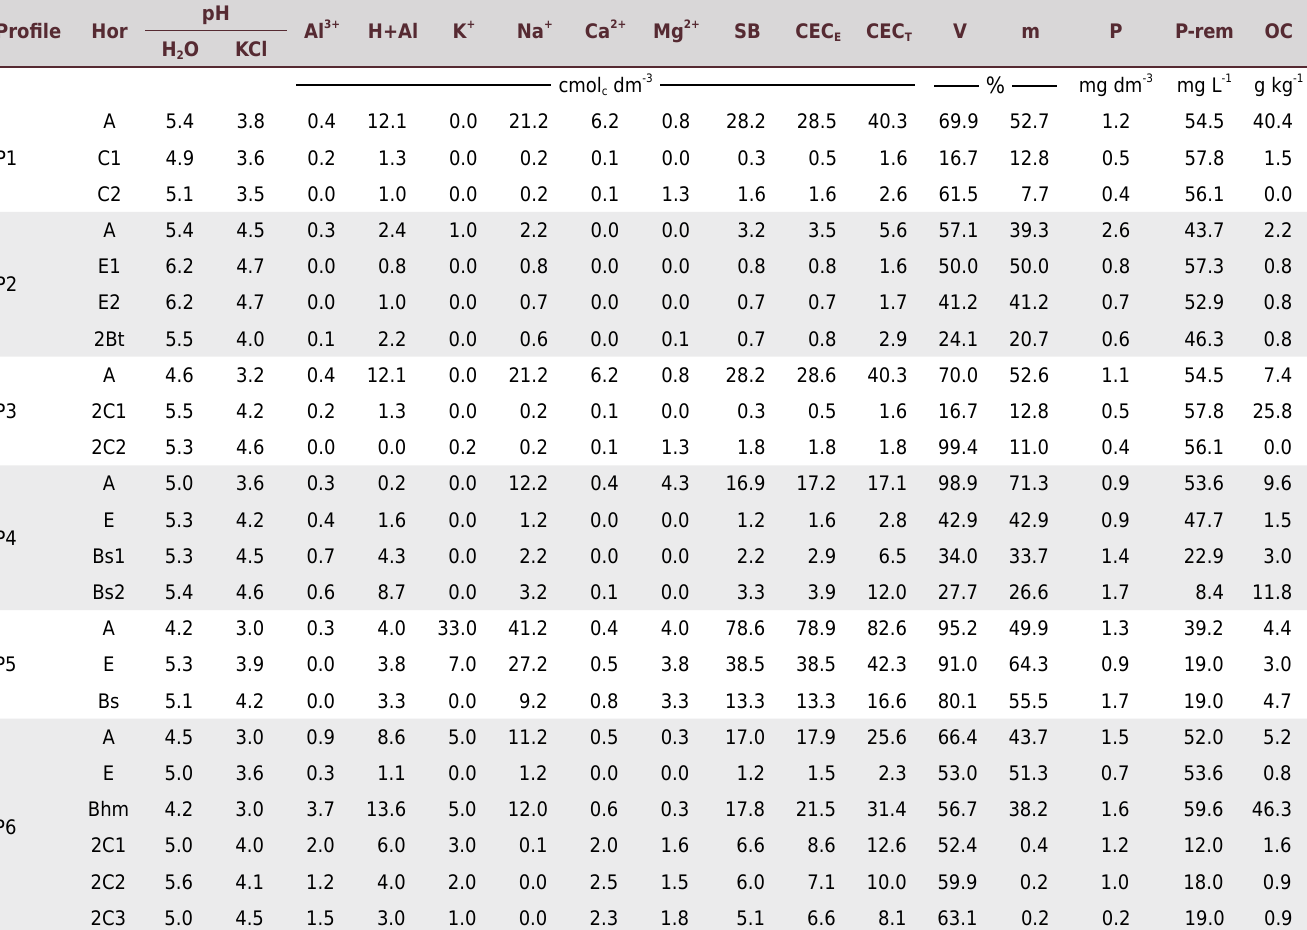
Table 3. Chemical characterization of soils in Barreiras Formation and Post-Barreiras environments, Bahia, Brazil pH Profile Hor Al